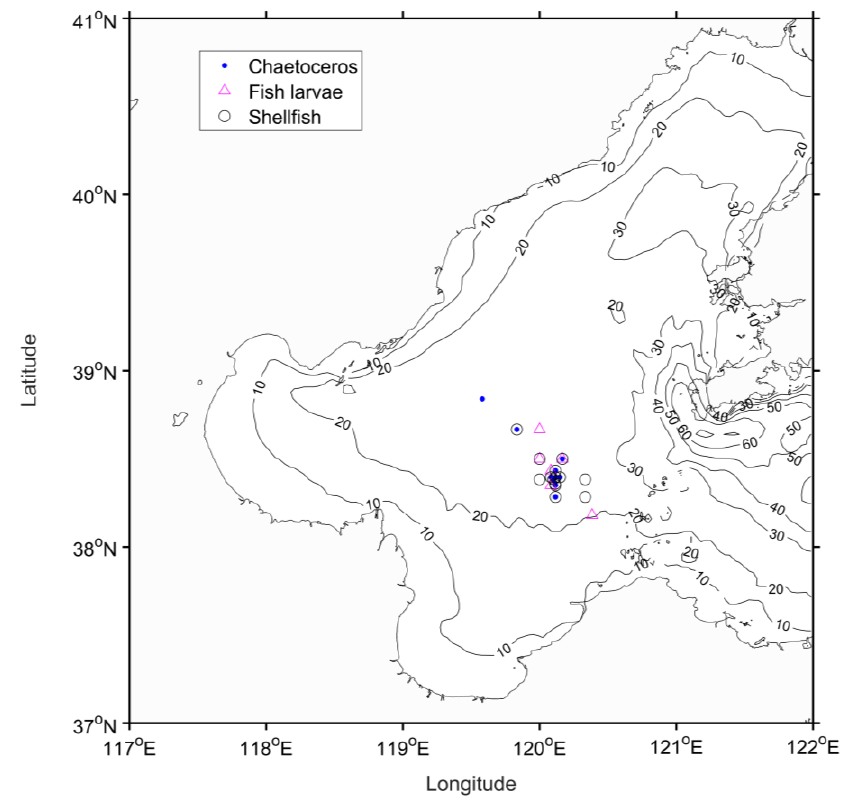
Figure 1. Distribution of sampling stations in the Bohai Sea in 2011. The dot, triangle and circle denote sampling stations of Chaetoceros , fish larvae and shellfish, respectively. Table 1. Observation information of Chaetoceros , fish larvae and shellfish: location and date.